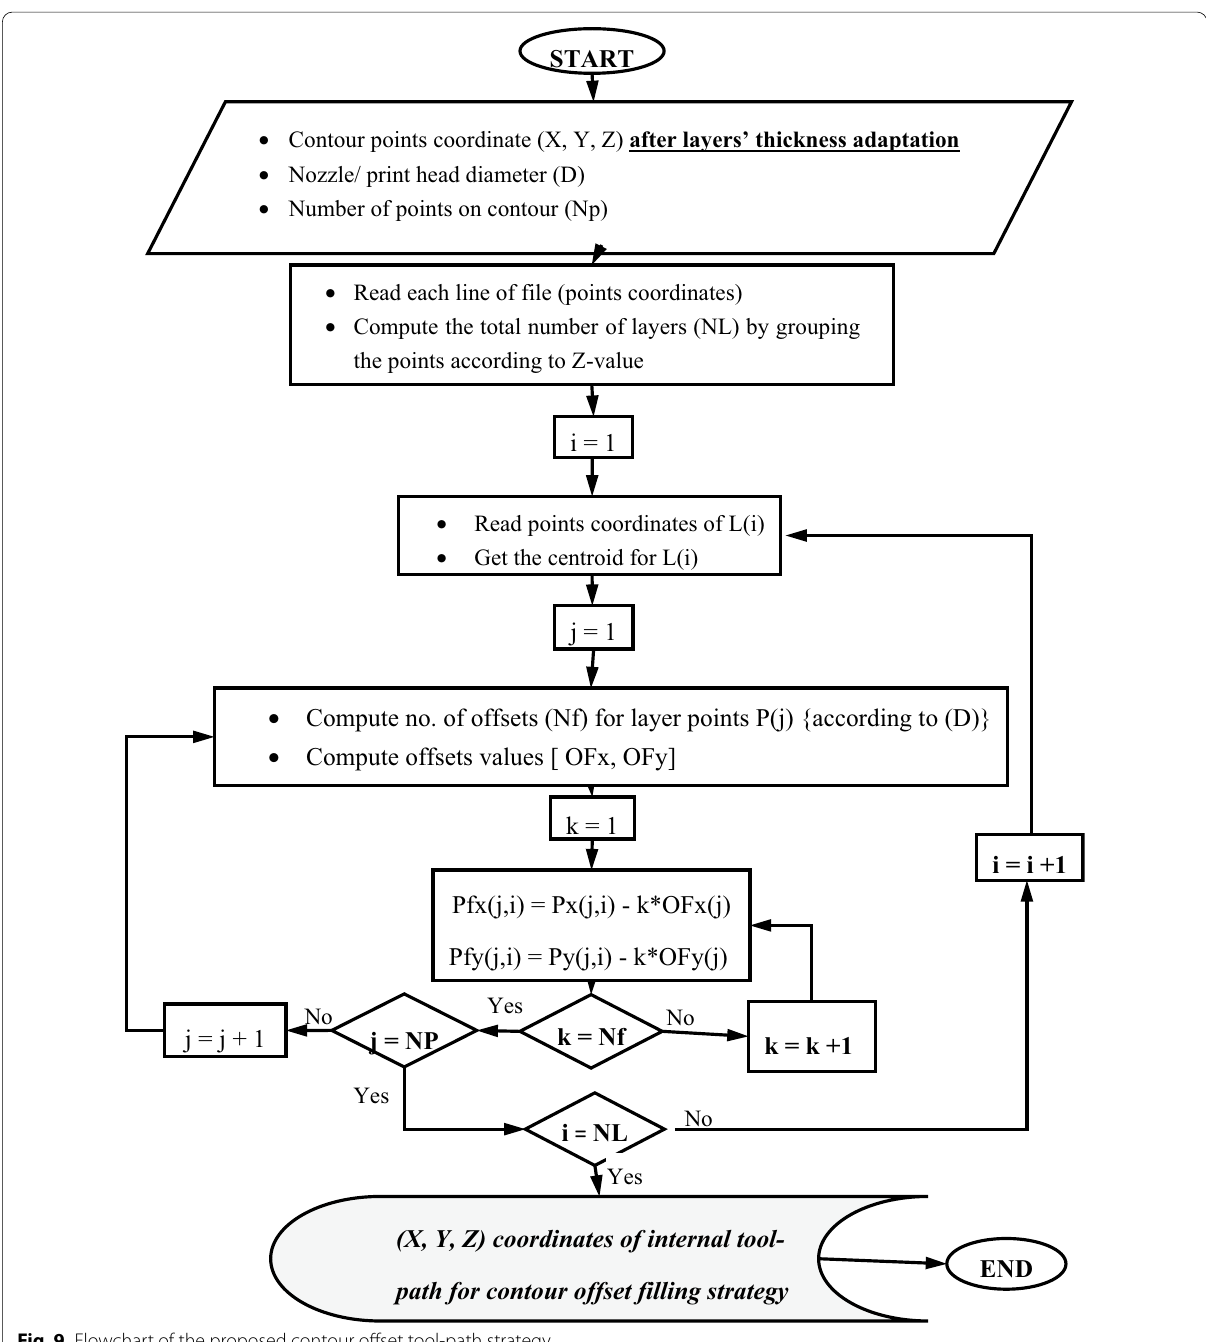
Fig. 9 Flowchart of the proposed contour offset tool-path